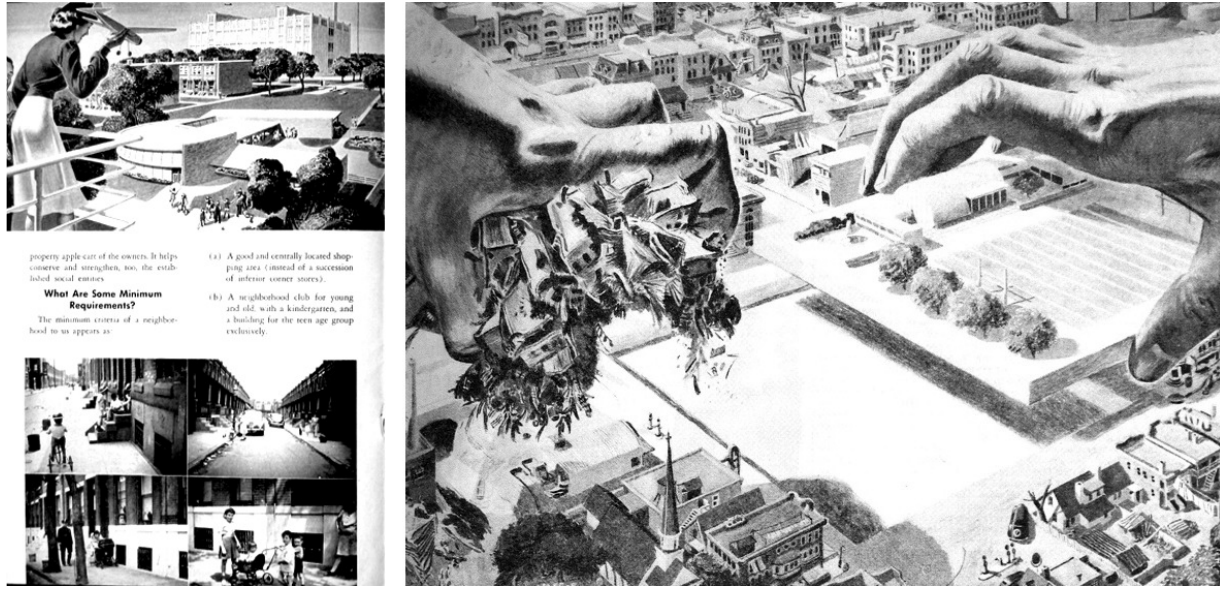
Figure 3. “Let YOURS be these helping hands.” Advertisements by Revere Copper & Brass of Why City Planning Is Your Responsibility and You and Your Neighborhood . Sources: Stonorov and Kahn (1942 [left], 1944